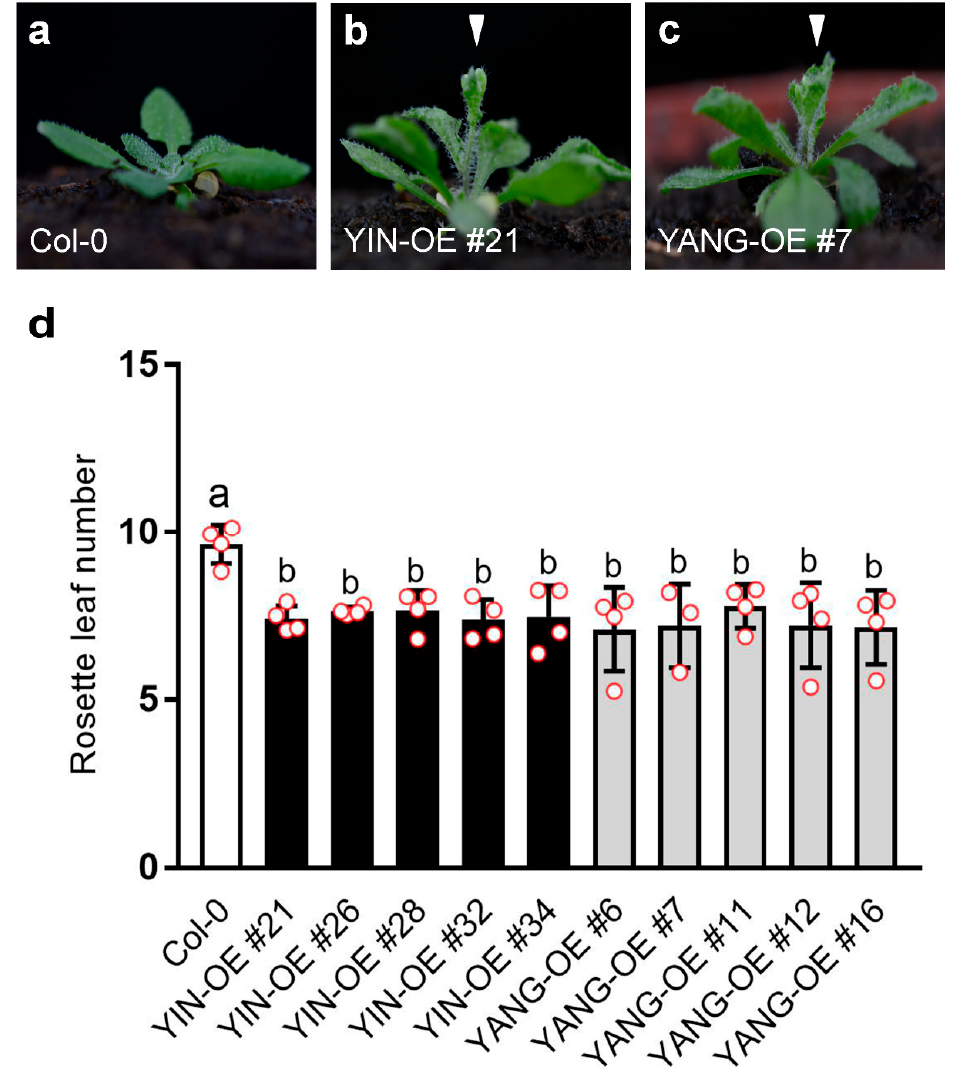
Figure 7. Expression of YIN and YANG accelerates flowering in Arabidopsis. ( a – c ) Arabidopsis plants, 30 DAG under the long-day conditions. YIN_OE ( b ) and YANG_OE lines ( c ) bolt earlier (arrowheads) than the wild-type control ( a , Col-0). ( d ) Rosette leaf number in the wild-type and transgenic YIN_OE and YANG_OE lines. The rosette leaf number was measured in four independent experiments (biological replicates; N = 4; YANG_OE #7 , N = 3). Red dots indicate the average in each biological replicate with at least 15 plants (N ≥ 15). Error bars represent the standard deviations. Statistical significance was determined by one-way ANOVA followed by a Tukey’s multiple comparisons test.